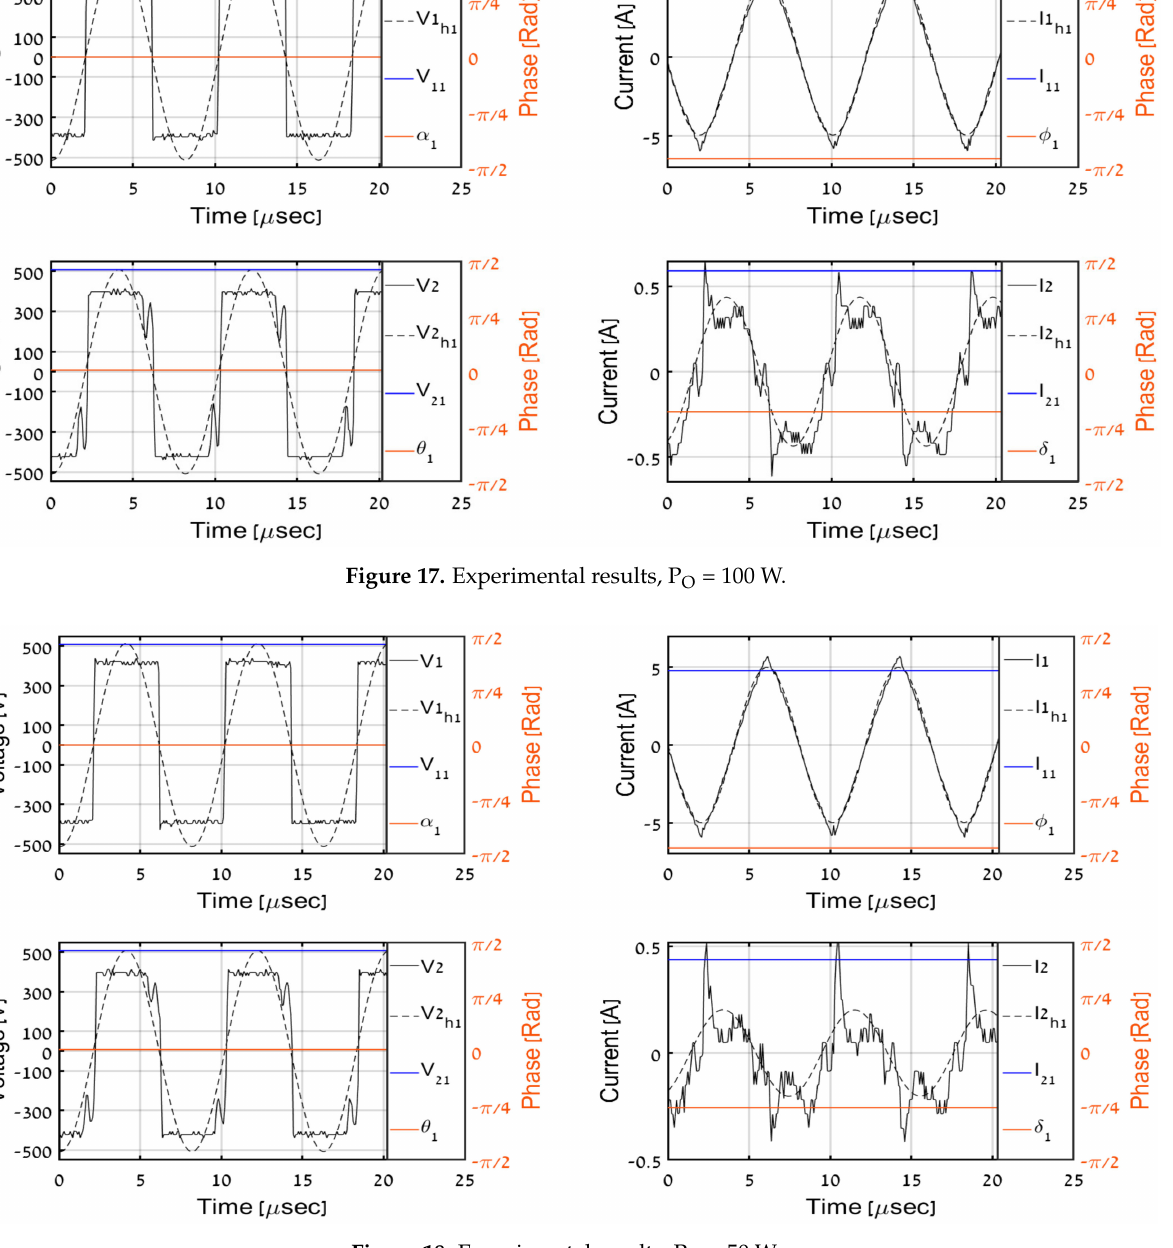
Figure 18. Experimental results, P O = 50